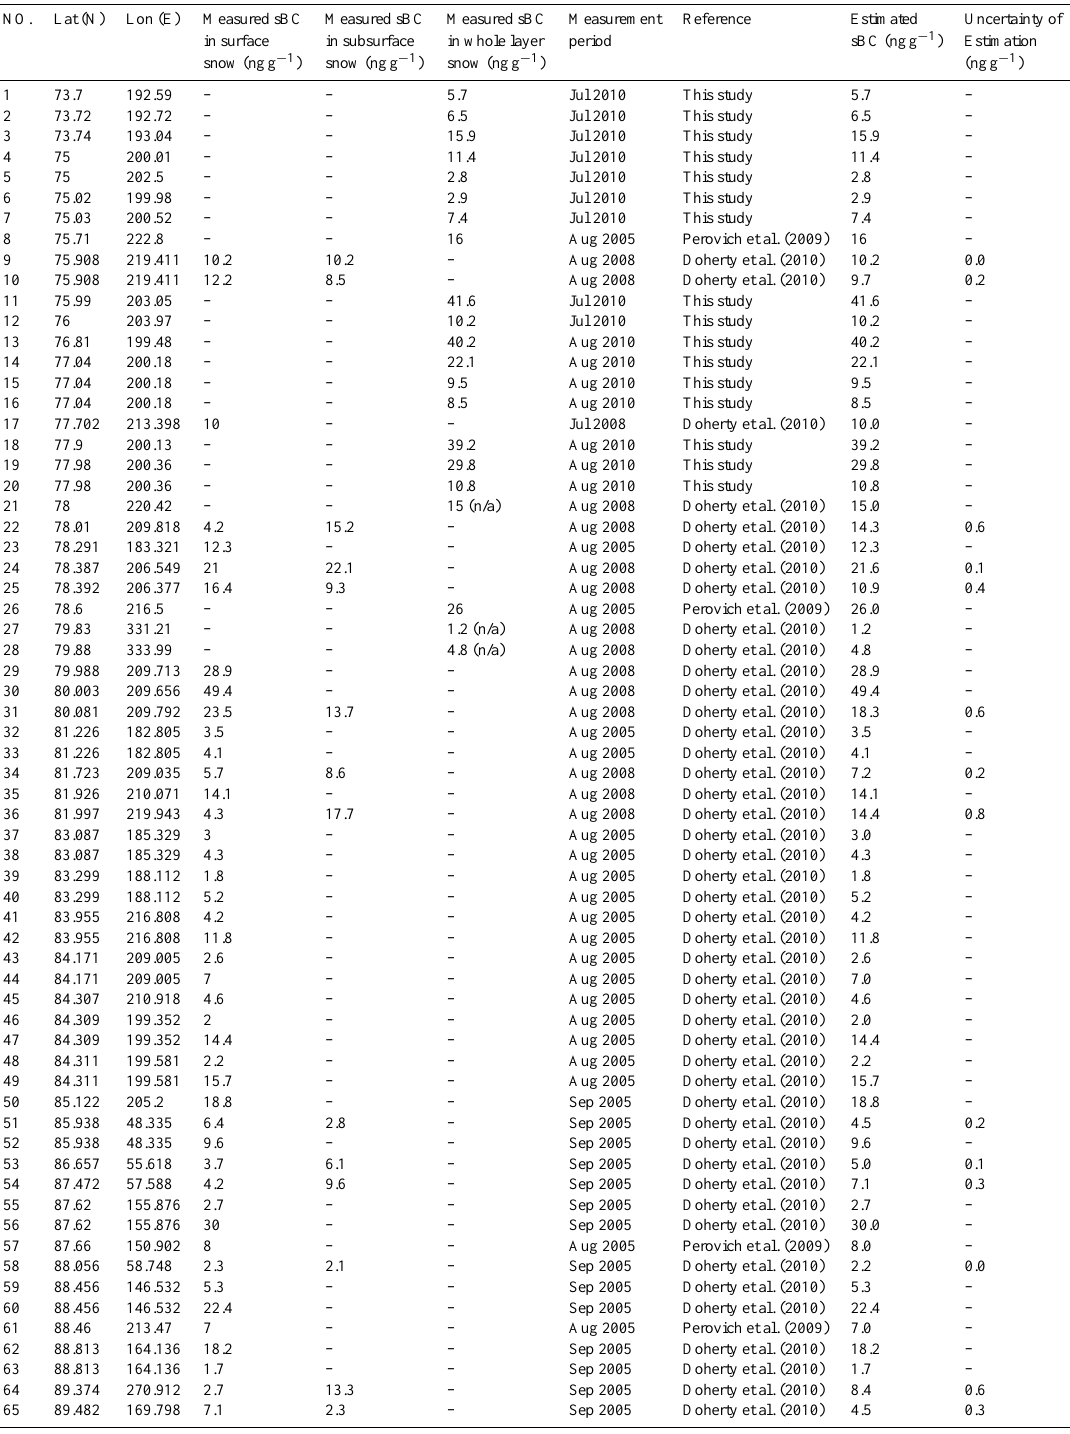
Table 3. Present-day sBC observations in the Arctic Ocean in summer. The estimated sBC of whole layer at each measurement site is calculated from surface and subsurface BC concentrations with snow densities observed in the 3rd Chinese Arctic expedition in summer 2008. Samples were collected on the sea ice surface, of melting sea ice, aged snow and newly-fallen snow from late July through late September. Thus, there are large uncertainties in current analysis, and present observations can only give a general and rough indication of the spatial distribution of sBC in summer. As the initial field of BC deposition, the Arctic Ocean is divided into several latitude zones in this study and each zone is characterized by one value averaged from the observations within this